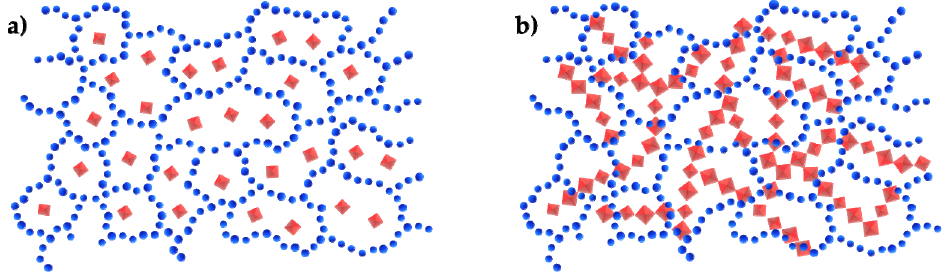
Figure 2. Class I hybrid materials.